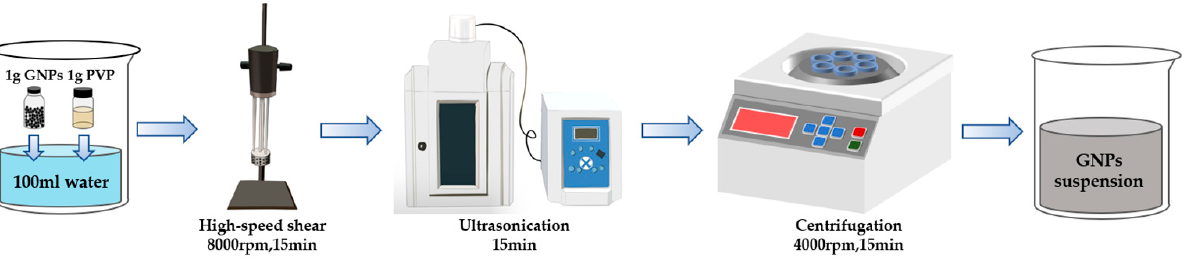
Figure 9. The optimal dispersion method of GNPs suspensions.